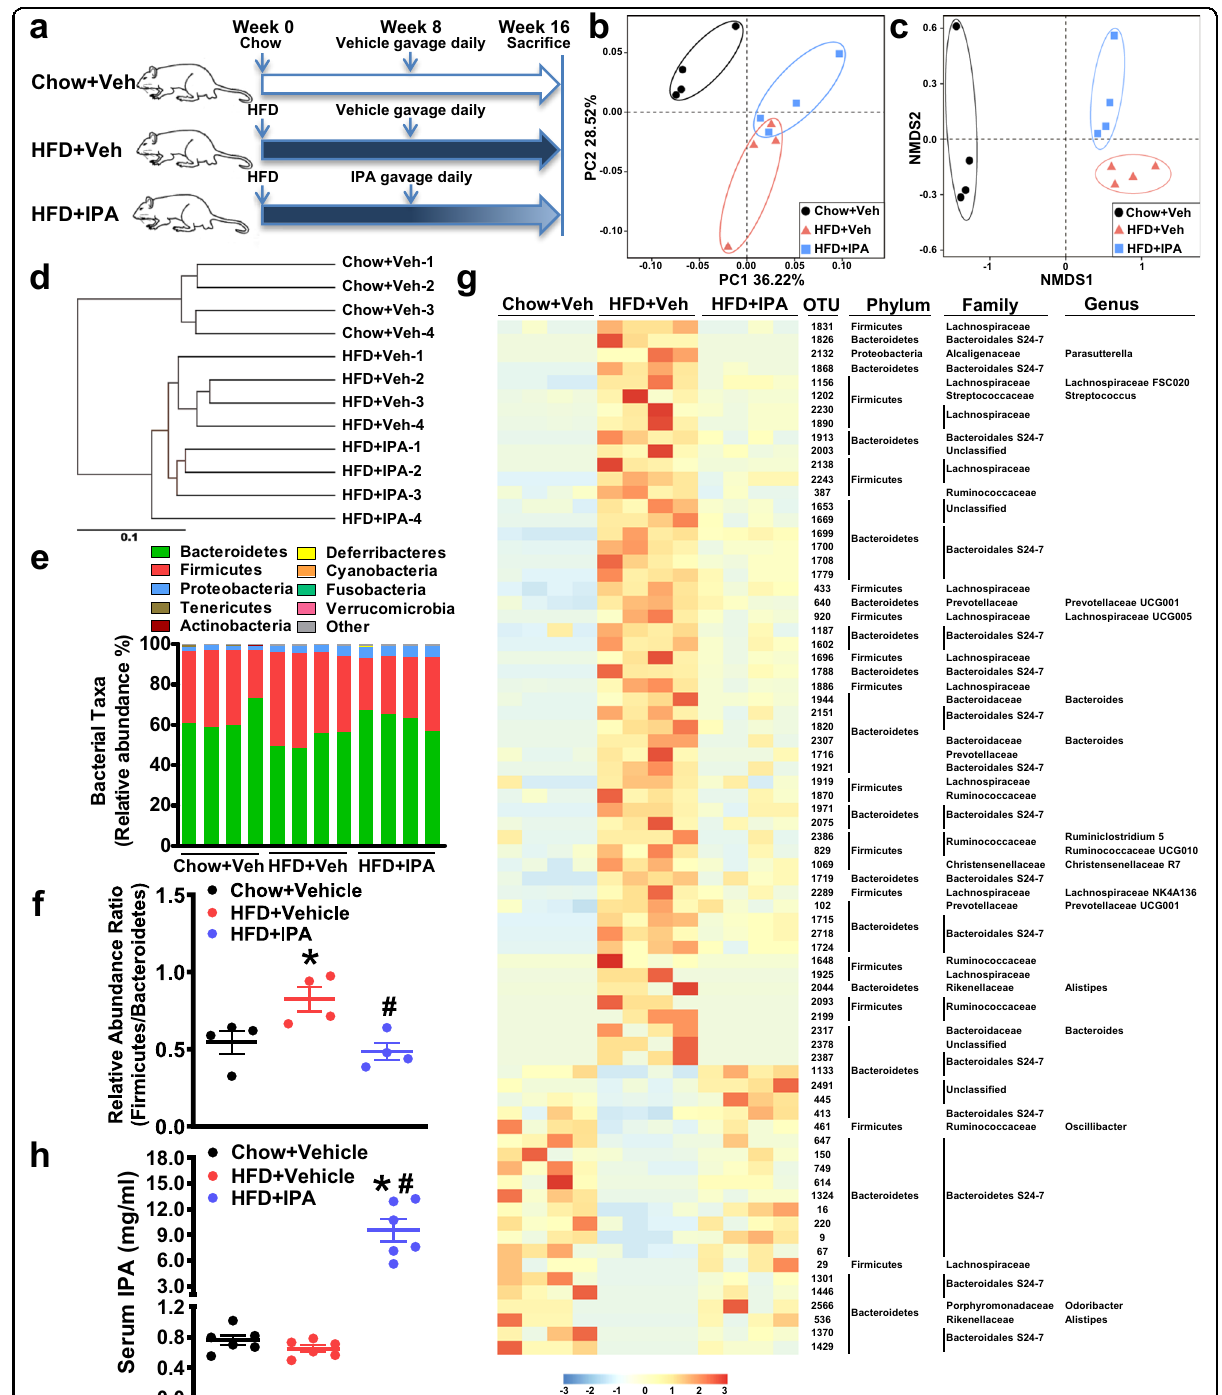
Fig. 1 Administration of IPA alleviates gut microbiota dysbiosis in rats fed a high-fat diet. Fecal samples of chow-fed, HFD-fed, and HFD-fed, IPA-treated rats were harvested at week 16. Genomic DNA was extracted from feces, and subsequent 16S rRNA-based gut microbial pro fi ling was performed. a Schematic illustration showing the design of the in vivo experiment. b Principal coordinate analysis (PCoA) of an unweighted UniFrac distance matrix. c Nonmetric multidimensional scaling (NMDS) analysis of a Bray – Curtis distance matrix. d UPGMA UniFrac clustering showing sample similarity. Relative abundance of taxa at the phylum level ( e ) and the Firmicutes to Bacteroidetes ratio ( f ). g Heatmap showing the abundance of OTUs signi fi cantly altered by the HFD and reversed by IPA treatment. Representative bacterial taxa information (phylum, family, and genus) is shown. h The serum levels of IPA were quanti fi ed. The data are presented as the mean ± SEM. n = 4 – 6, * P < 0.05, vs. rats fed a chow diet; # P < 0.05, vs. rats fed a high-fat